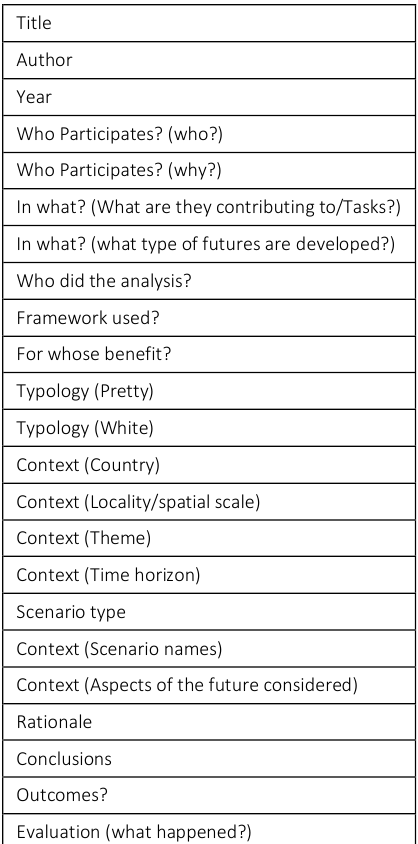
Table A1.1. Review protocol with questions answered for each reviewed